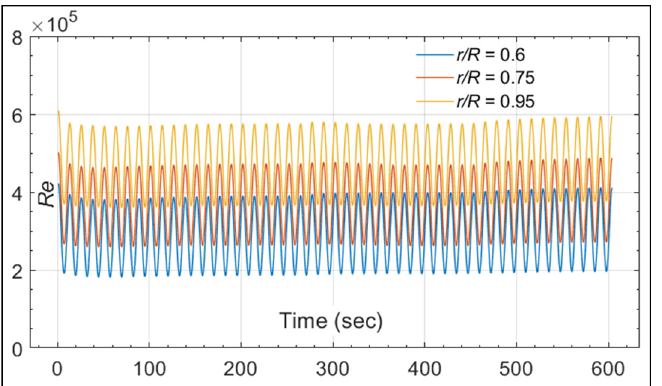
Figure 18. Example of the Re Variation versus Time at the Three Blade Sections r/R = 0.6, 0.75 and 0.95 for the Anti-Icing Test #2 ( Ω = 900 RPM and V ∝ = 20 m/s).